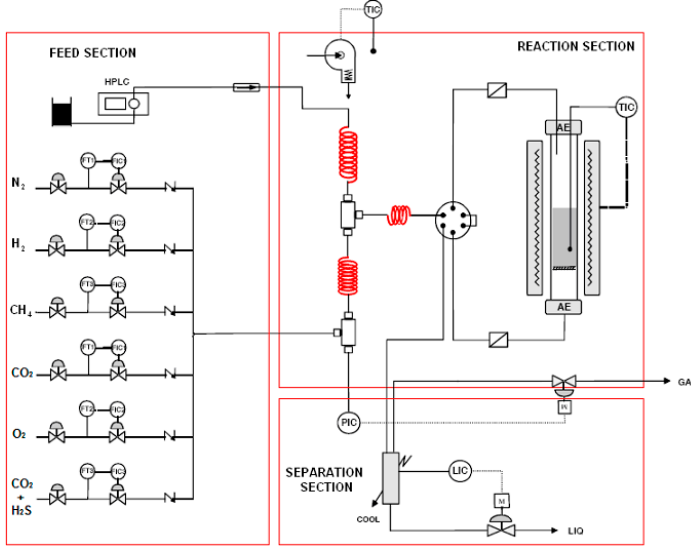
Figure 7. Scheme of the Microactivity plant.